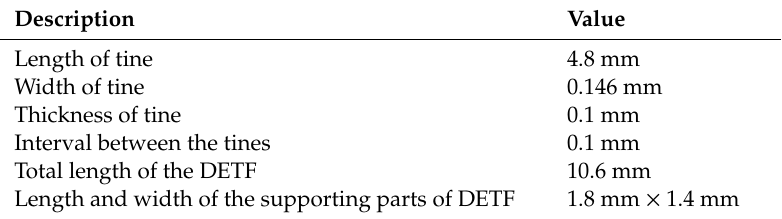
Figure 2. The electrode patterns of the double-ended tuning forks (DETF). Table 1. The detailed dimensions of the